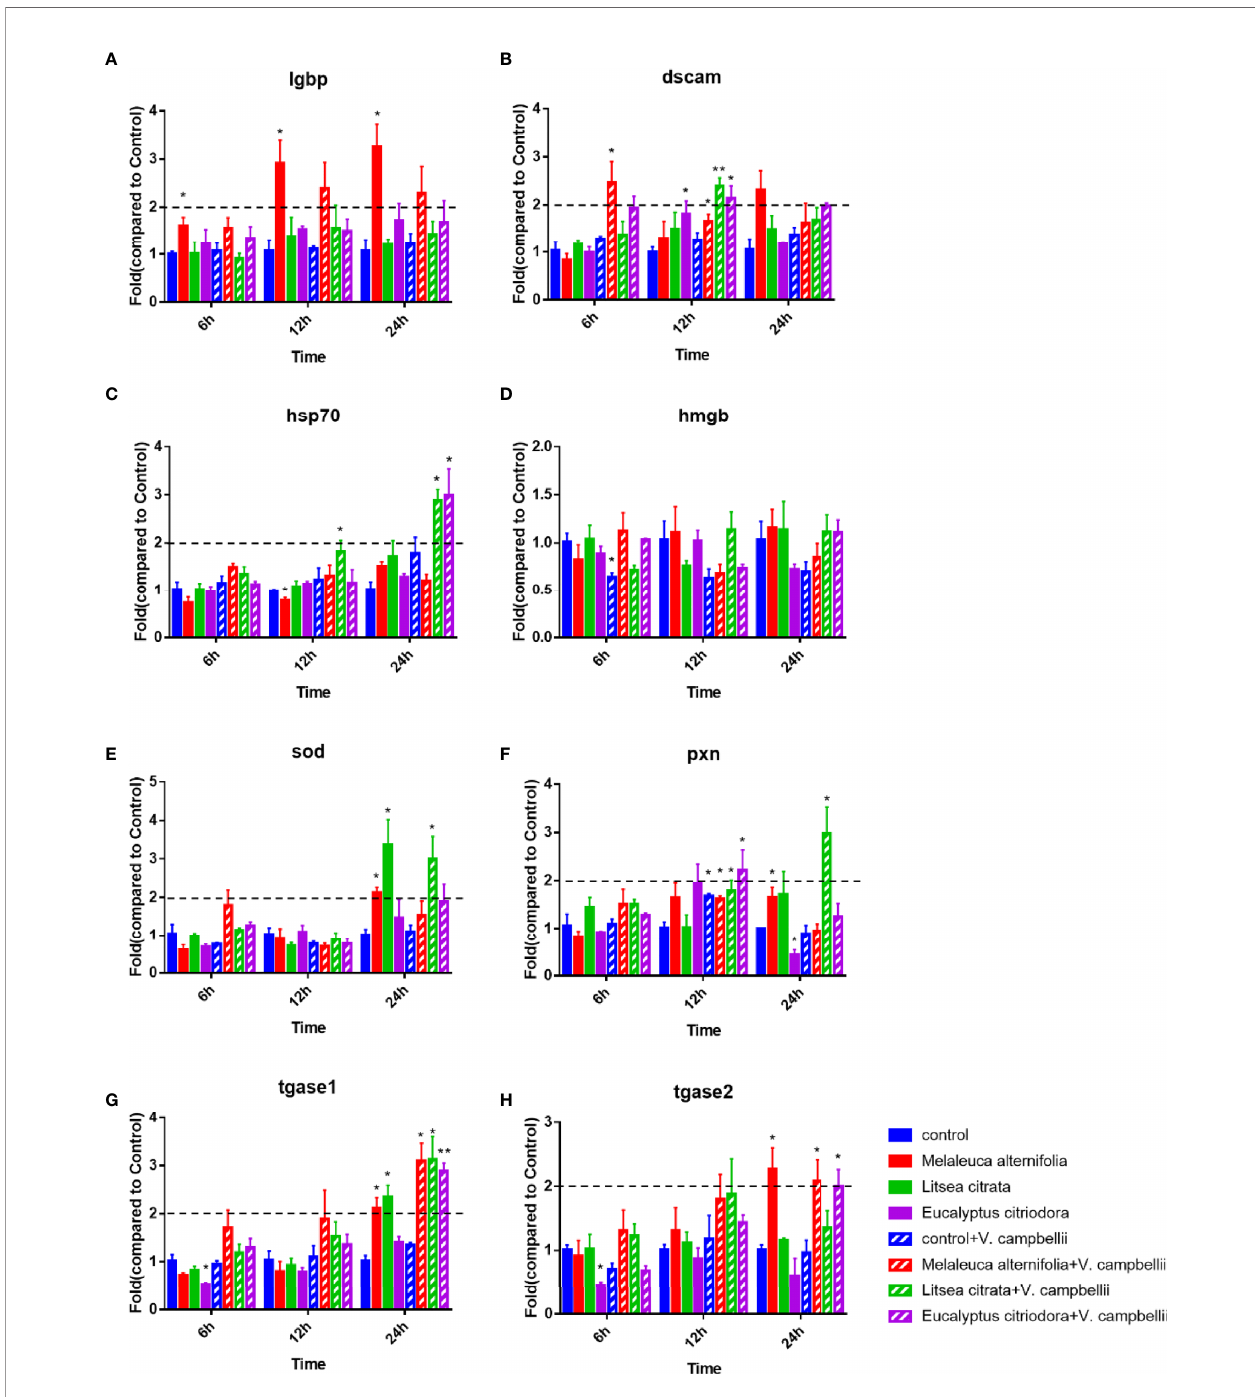
FIGURE 3 | Relative expression of lgbp (A) , dscam (B) , hsp 70 (C) and hmgb (D) , sod (E) , pxn (F) , tgase 1 (G) , and tgase 2 (H) genes in Artemia larvae. The unchallenged Artemia larvae served as control. For each gene, the expression in control was set at 1, and the expression in different treatments was normalized accordingly using the 2 − DD CT method. The geomean of the EF-1 and GAPDH was used as internal control. Data were average ± standard error of three replicates. Asterisks indicated a signi fi cant difference when compared to control (independent samples t-test; * P < 0.032; ** P < 0.0021). EF-1, elongation factor 1; GAPDH, glyceraldehyde-3-phosphate dehydrogenase; lgbp , lipopolysaccharide and b -1,3-glucan-binding protein; dscam , down syndrome cell adhesion molecule; hsp 70 , heat shock protein 70; hmgb , high mobility group box protein; sod , superoxidase dismutase; pxn , peroxinectin; tgase 1 , transglutaminase 1; tgase 2 , transglutaminase